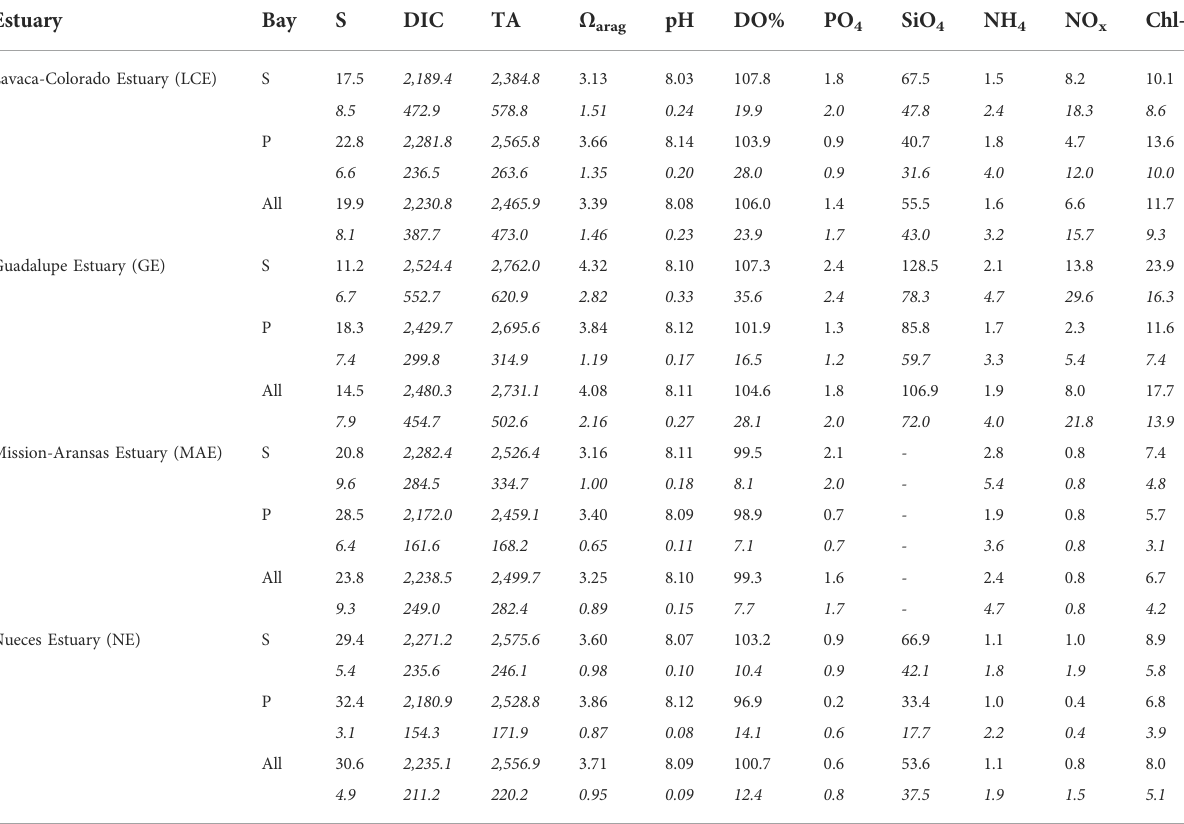
TABLE 2 Mean and standard deviations of measured water chemistry variables in the four studied nwGOM estuaries during